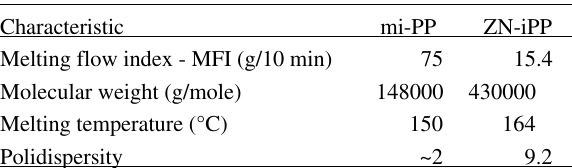
Table 2. Some characteristics of the commercial metallocenic polypropylene (mi-PP) and Ziegler-Natta polypropylene (ZN-iPP) used for blends